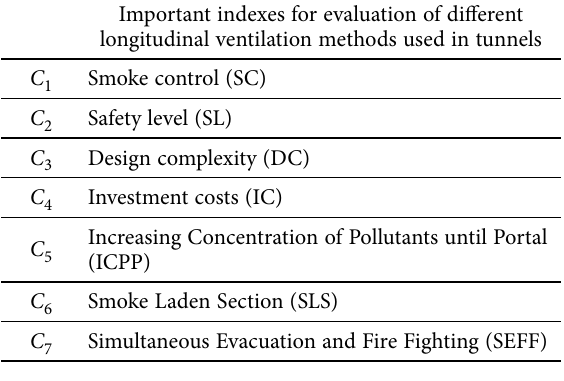
Selecting the optimal method of mechanical longitudinal ventilation of the